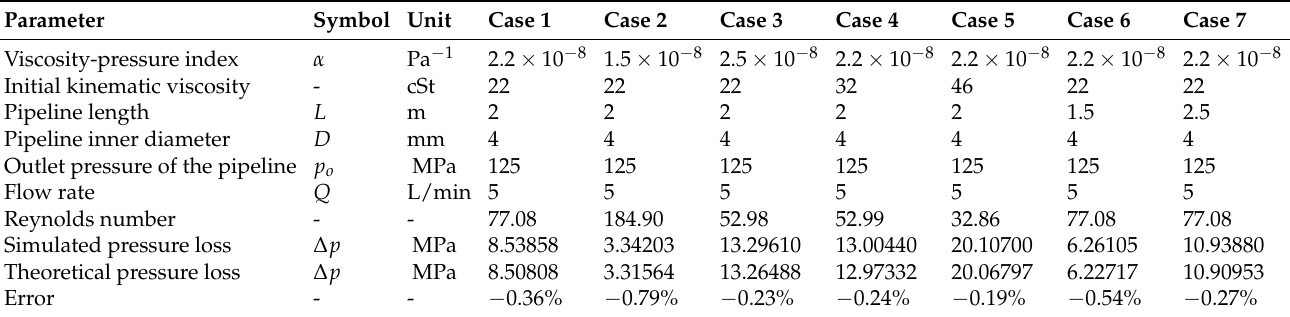
Table 3. Variable inputs and pressure losses: part A.